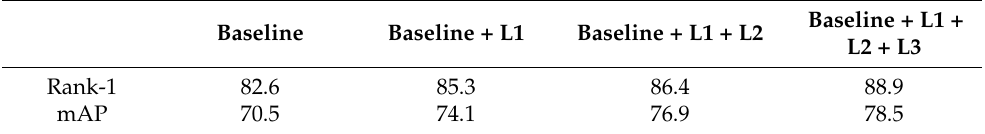
Table 3. Comparison of ablation experiment results